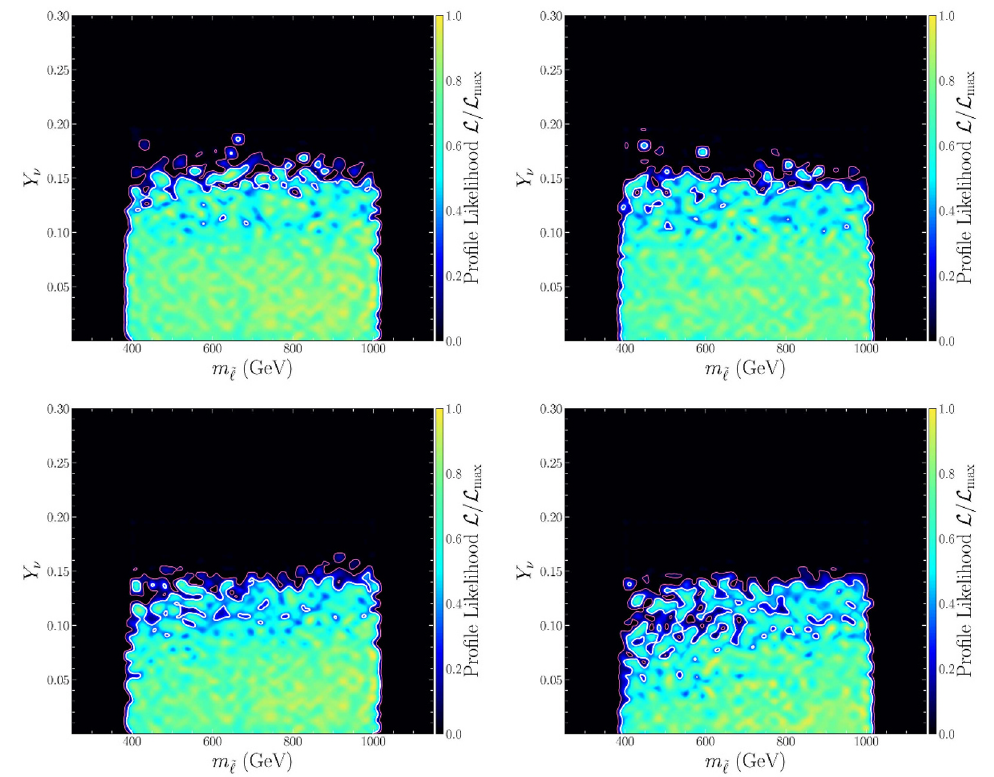
Figure 4 . Same as figure 1, but for the profile likelihood projected onto Y ν − m ˜